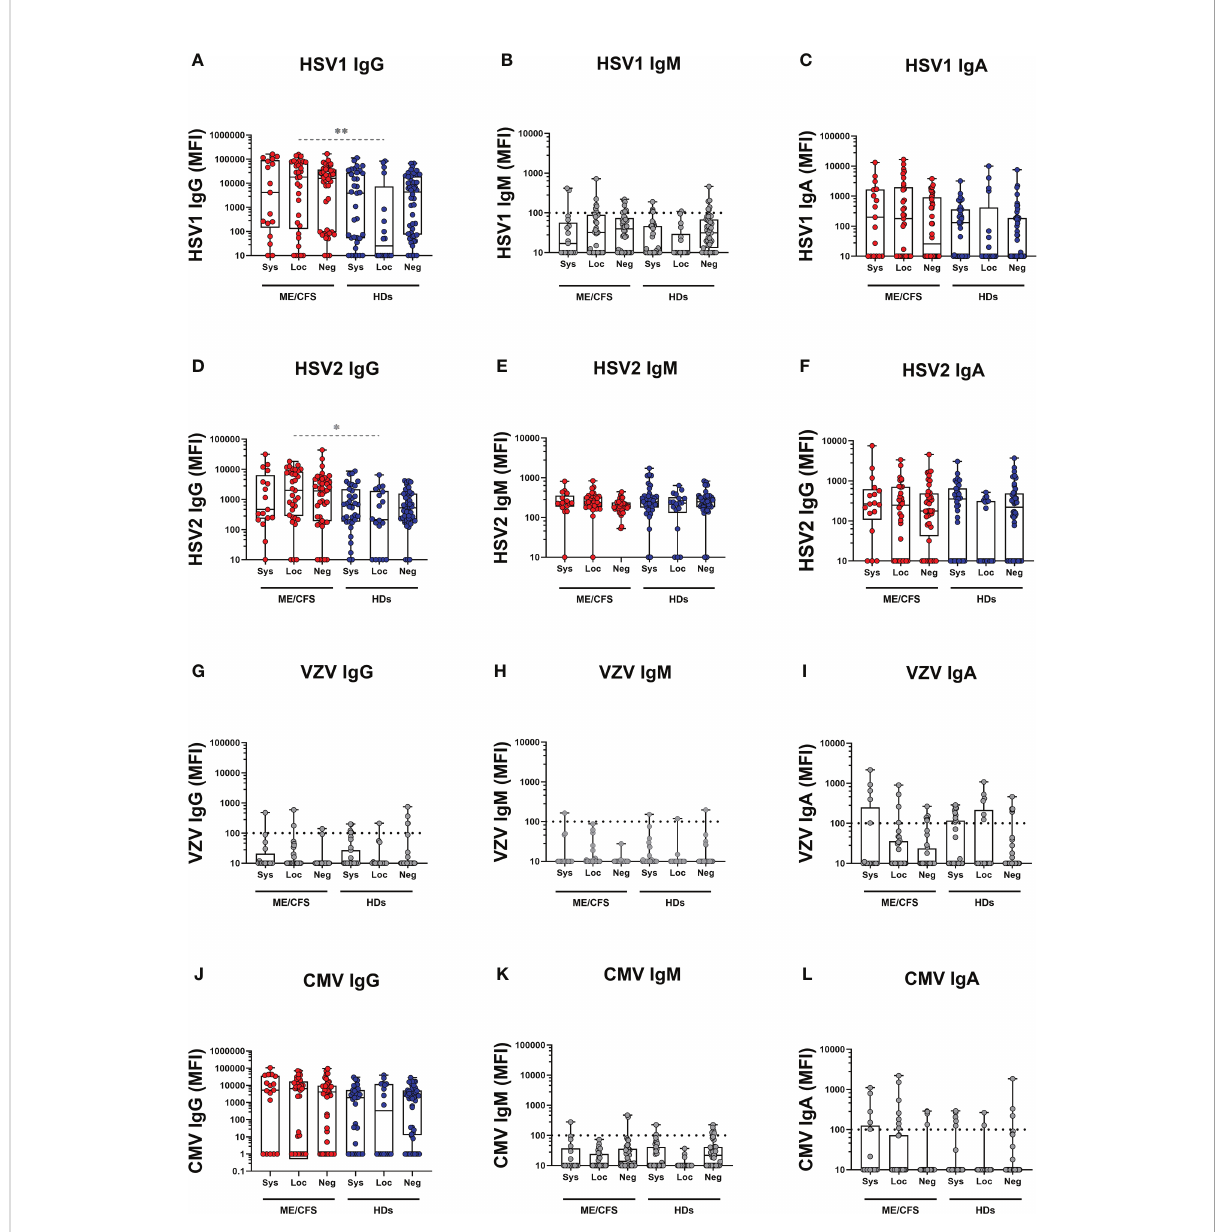
FIGURE 4 Saliva antibody reactivity to herpesviruses in patients with ME/CFS (ME) and healthy donors (HDs). (A herpes simplex-1 virus (HSV1) IgG, (B) HSV1 IgM, (C) HSV1 IgA, (D) herpes simplex-2 virus (HSV2), (E) HSV2 IgM, (F) HSV2 IgA, (G) varicella zoster virus (VZV), (H) VZV IgM, (I) VZV IgA, (J) human cytomegalovirus (CMV) IgG, (K) CMV IgM, (L) CMV IgA. Systemic: Participants RBD-positive for systemic response in plasma. Sys, participants RBD-positive for systemic response in plasma. Loc, participants RBD-positive for local response in saliva. Neg, participants RBD- negative both in plasma and saliva. Data are presented as boxplots with median values with 25 th and 75 th percentile. MFI, median fl uorescence index. Statistically signi fi cant differences according to non-parametric Kruskal-Wallis procedure and false discovery rate adjustment (5%), are indicated as * p < 0.05 , ** p < 0.01 Dimmed p-value asteriks* indicate in fl uence of confounding factor. Dimmed dots and dashed line indicates absence of antibodies (assay background levels). Dimmed/grey p -value asteriks* indicate loss of signi fi cance after confounding factor (age and gender) analysis with multiple linear regression and adjustment for FDR of 5% according to Benjamini, Krieger,